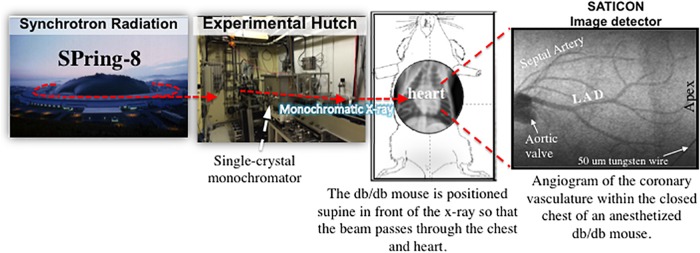
A schematic diagram showing the experimental set-up for coronary microangiography in an anesthetized mouse model using monochromatic synchrotron radiation at the SPring-8 facilities in Hyogo, Japan (modified from Pearson et al., 2018).